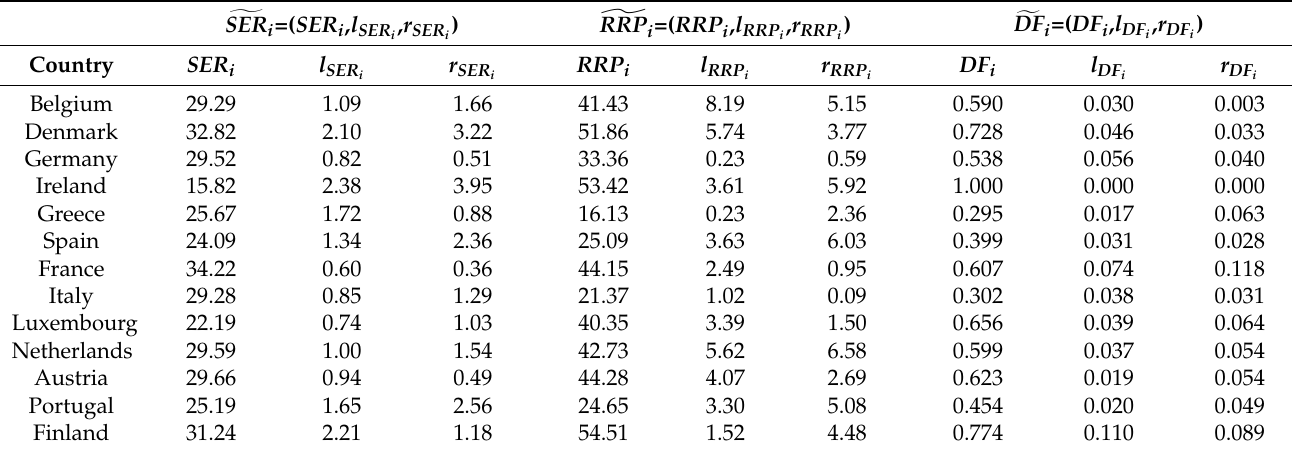
Table 6. Fuzzy observations on social expenses over GPD, relative reduction of poverty-at risk index and Debreu–Farrell measure in the period